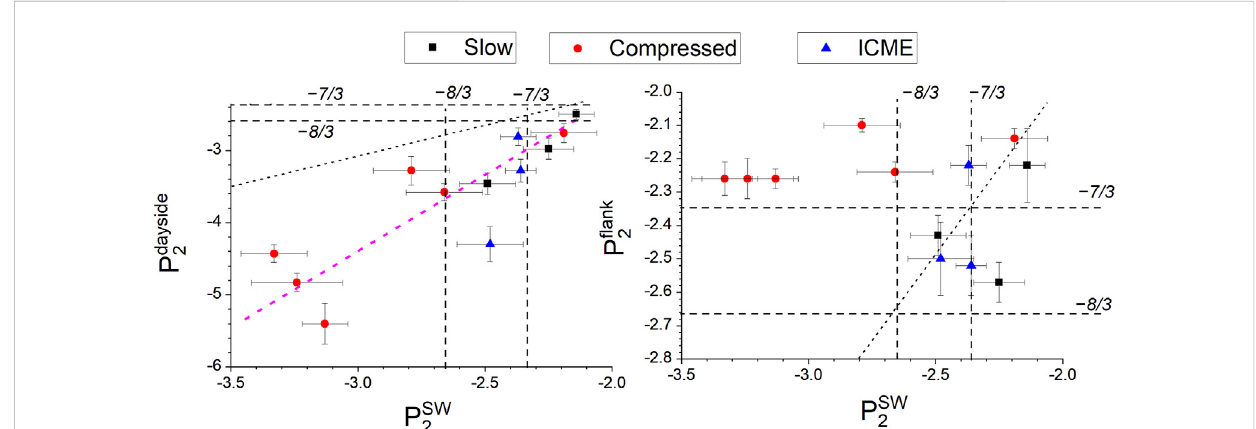
FIGURE 2 Spectral slopes at the frequencies higher than the ion spectral break in the dayside magnetosheath (left) and at the fl ank (right) versus same slopes upstream from the bow shock for three types of the solar wind; dotted lines show equal values of the downstream and upstream slopes, and magenta dashed line presents the linear fi t (adopted from Rakhmanova et al., 2022; fi gure 6c, d, distributed under the terms of the Creative Commons Attribution 4.0